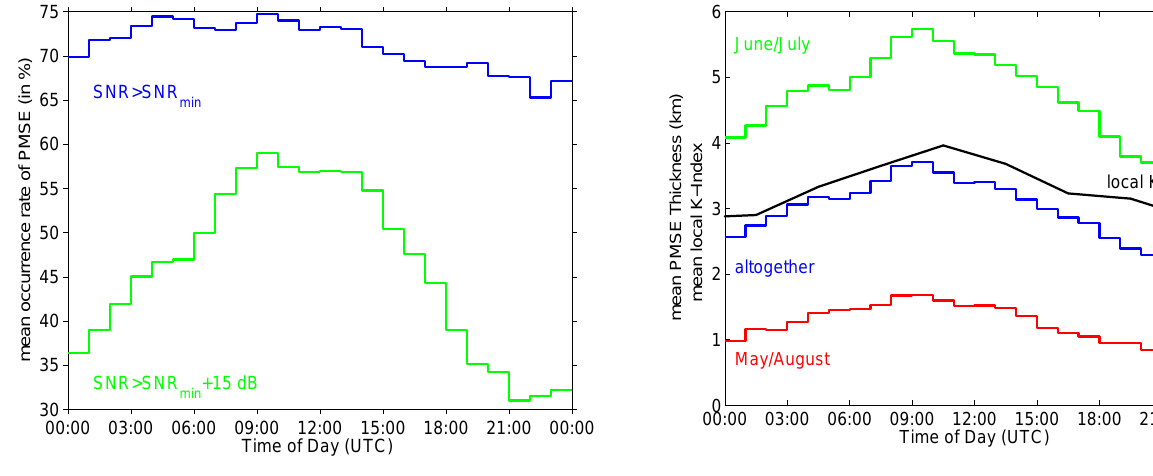
Fig. 6. Mean diurnal variation of PMSE occurrence during five summers between 1999 and 2004 for different thresholds: SNR > SNR min (blue curve) and SNR > SNR min +15dB (green curve, indicating strong events).